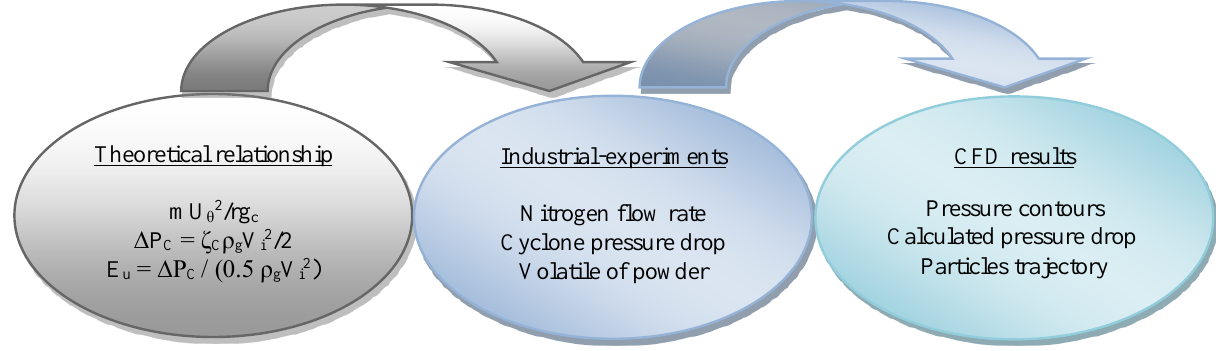
Figure 7. Schematic of study in double-cyclone